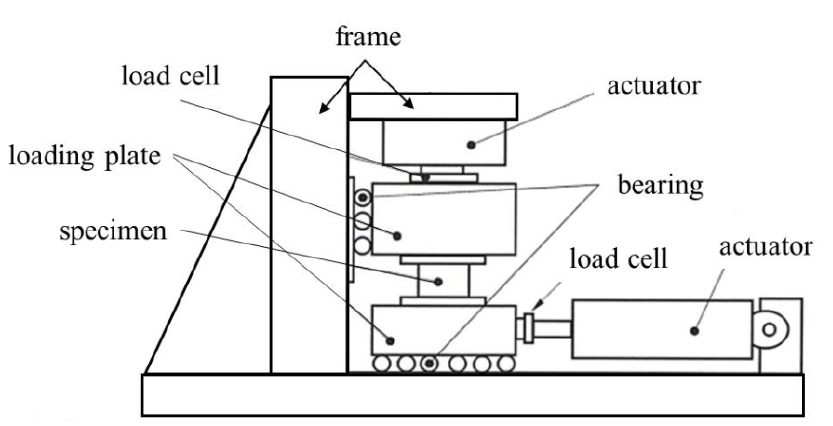
Figure 5. Conceptual drawing of compressive-shear test